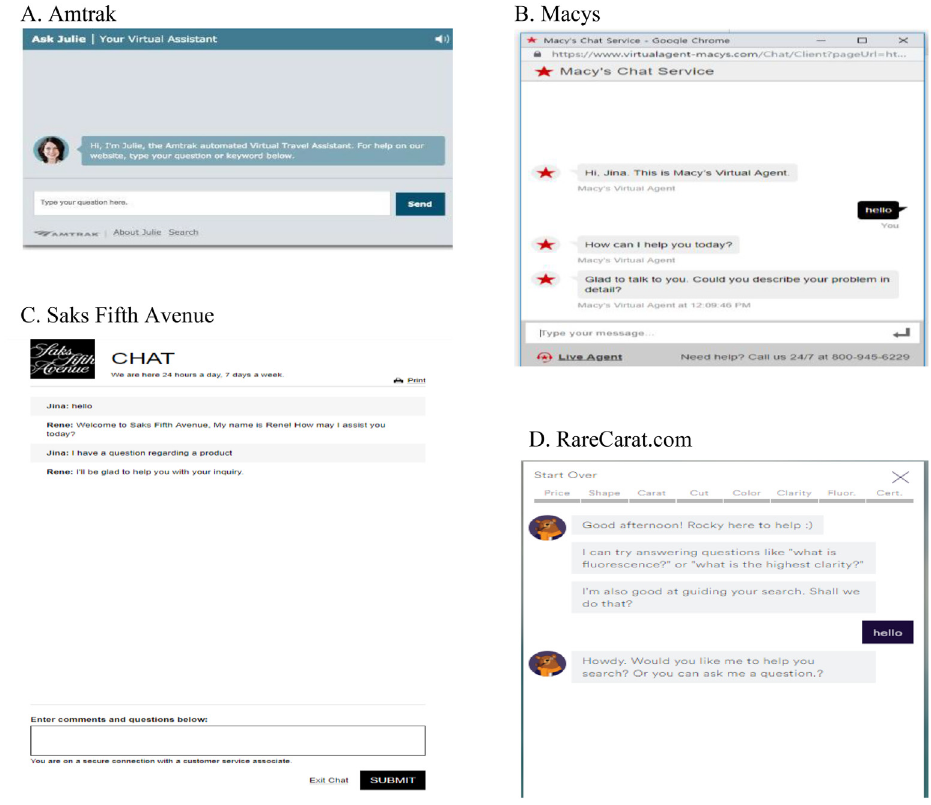
Fig. 1. Examples of presentations of customer